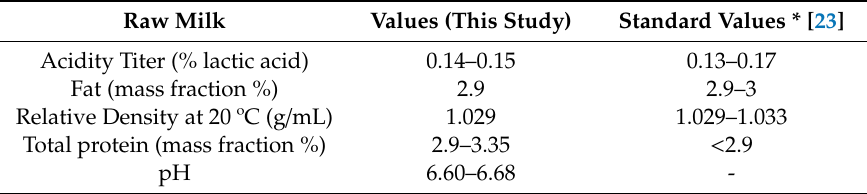
Table 1. Pasteurized whole milk